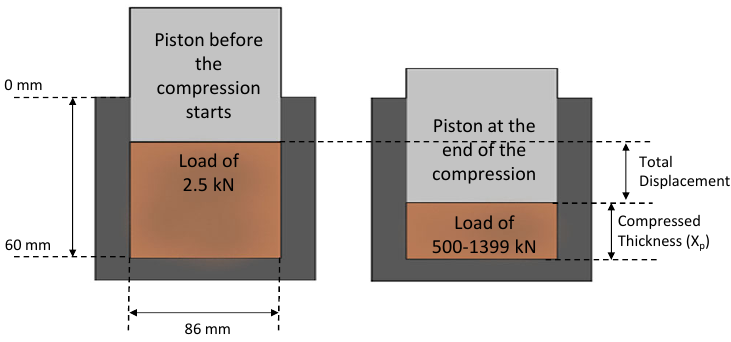
Figure 3. PPT procedure scheme